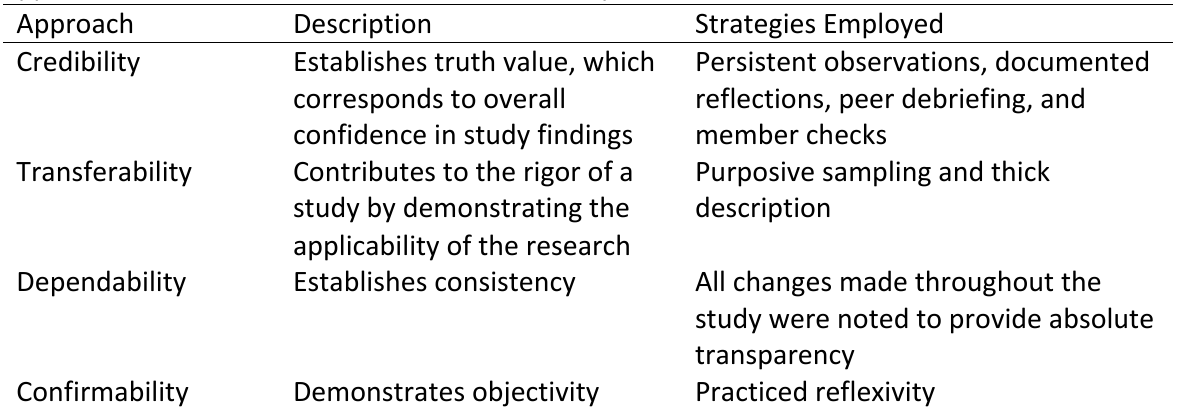
Approaches to Ensure Trustworthiness and